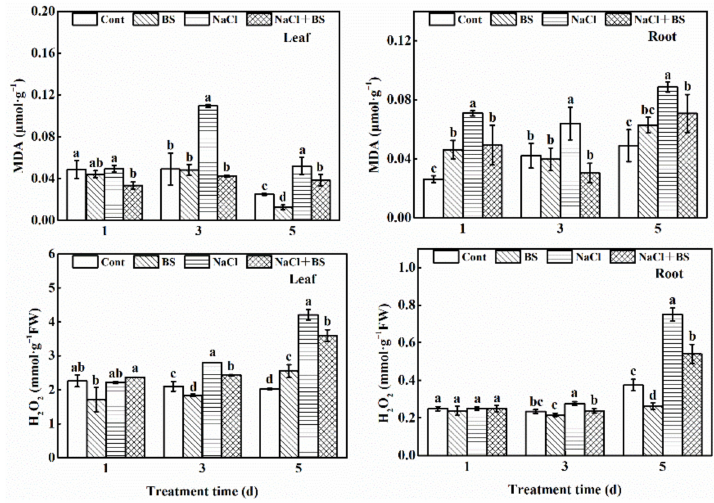
Figure 6. Effects of B. cereus on contents of MDA and H 2 O 2 in cucumber seedlings under salt stress. Bars represent standard errors. Different letters indicate a significant difference in the same parameter between treatments at p <